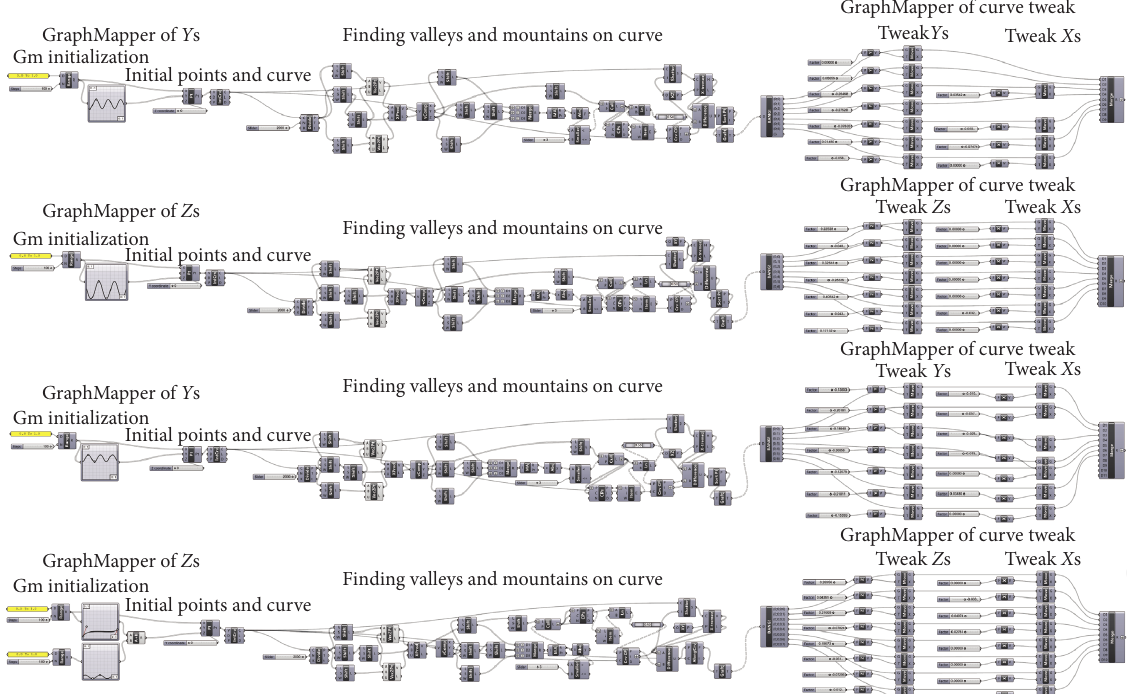
Figure 13: Case study of a complex parametric model using the grasshopper logic system (source: drawing by the research